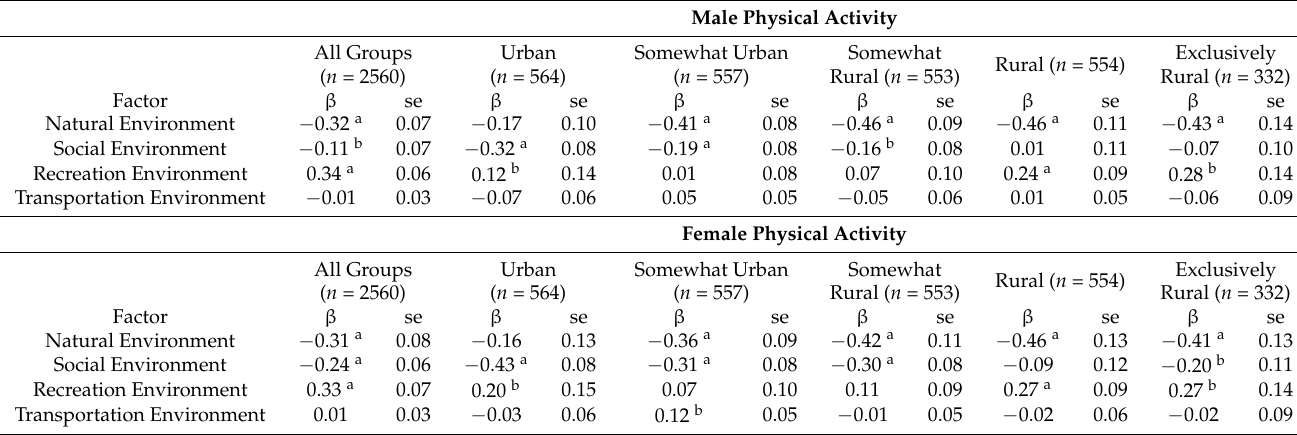
Table 4. Standardized Regression Coefficients and Standard Errors for Multiple Linear Regression of 2011 Male and Female Prevalence of Meeting Physical Activity Guidelines by Environmental Factor